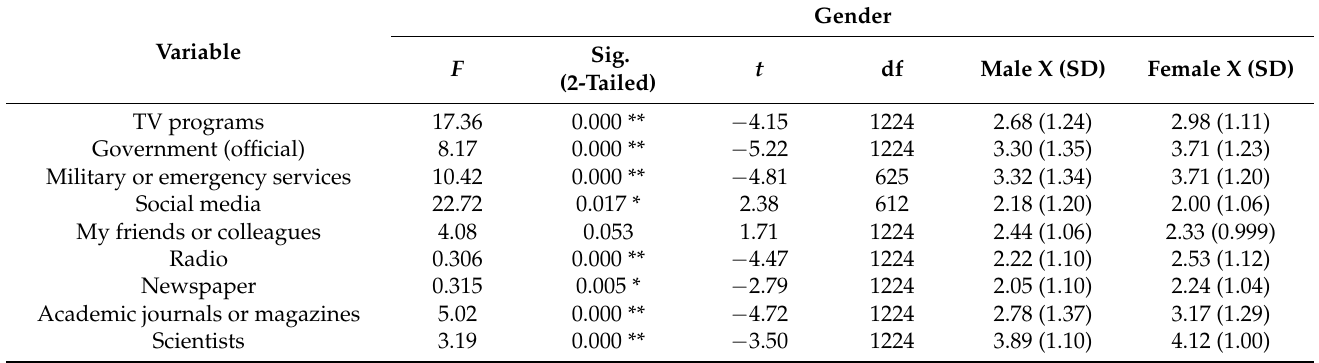
Table 8. Independent samples t -test results for gender and the information sources of citizens to receive information about